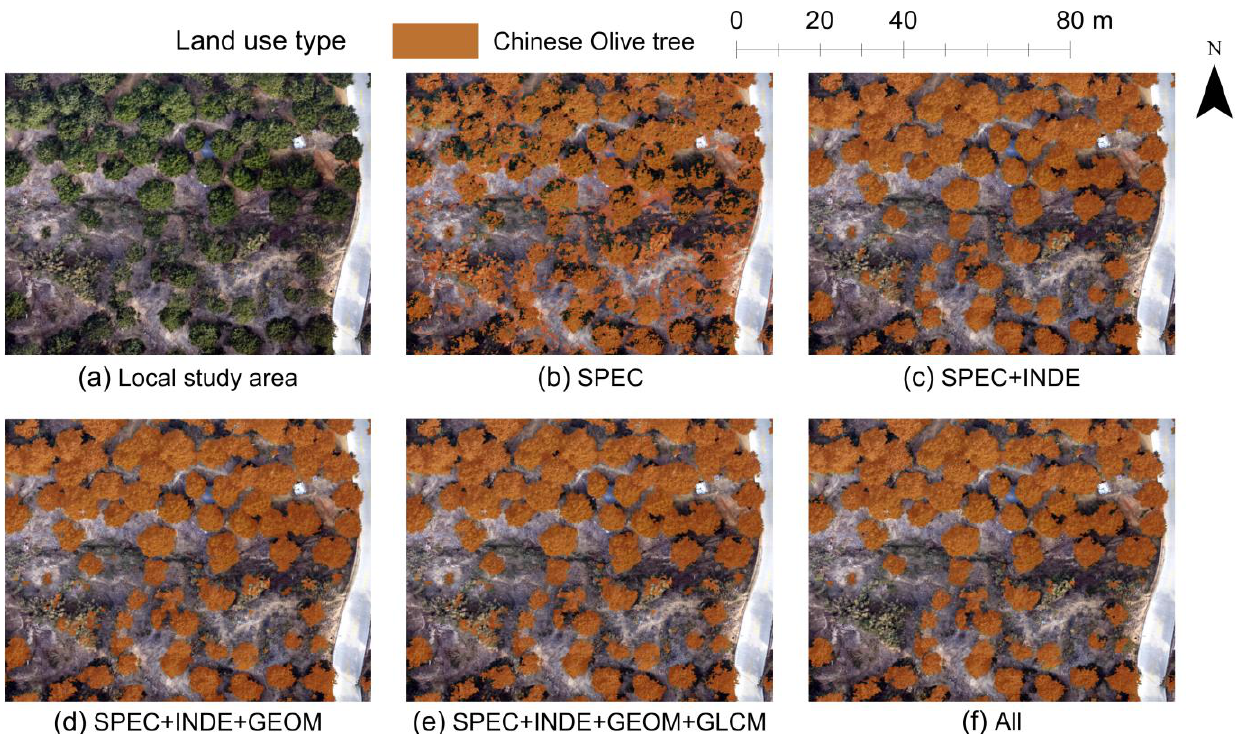
Figure 8. Extraction results of different feature combination schemes of OBIA-RF: ( a ) local study area; ( b ) spectral feature only; ( c ) spectral and vegetation index features; ( d ) spectral, vegetation index and geometric features; ( e ) spectral, vegetation index, geometric and textural features; ( f ) all features.